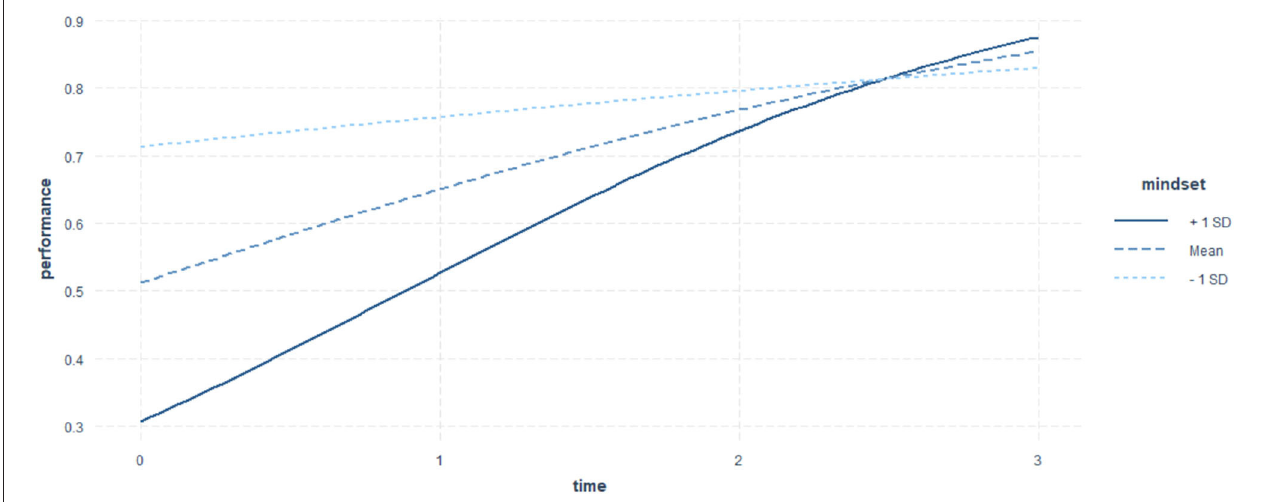
FIGURE 2 | The effect of mindset over test time point. The x -axis represents the predictor Test Time Point with three levels: 0 = Pretest, 1 = Immediate posttest, 2 = 2-month posttest, and 3 = 5-month posttest. The y -axis represents the predicted response variable: Test Performance measured by the binary scores (0 or 1). The growth mindset moderator is represented by the three curves, where the bolded full curve represents the participant with growth mindset at the value of Mean + 1 SD (17.66 + 1.64), the dashed line in dark blue represents the participant with growth mindset at the value of Mean (17.66), and the dashed line in light blue represents the participants with growth mindset at the value of Mean − 1 SD (17.66 – 1.64). The trajectories of the three curves demonstrate the changes of test performance with different levels of growth mindset. Participants with the highest growth mindset (Mean + 1 SD) demonstrate highest improvements from the pretest to the last posttest. Although they are predicted to perform the poorest on the pretest, GLMM shows that they are likely to surpass the participants with average and lower growth mindset after the 2-month posttest and perform best among all participants. In contrast, participants with the lowest growth mindset (mean − 1 SD) showed the least improvements in knowledge retention. Finally, participants with an average endorsement of growth mindset show a moderate improvement on the test performance over time. The figure shows that participants with higher levels of growth mindset generally show greater improvements over time (i.e., from the pretest, to the immediate, to the 2-months, and to the 5-month